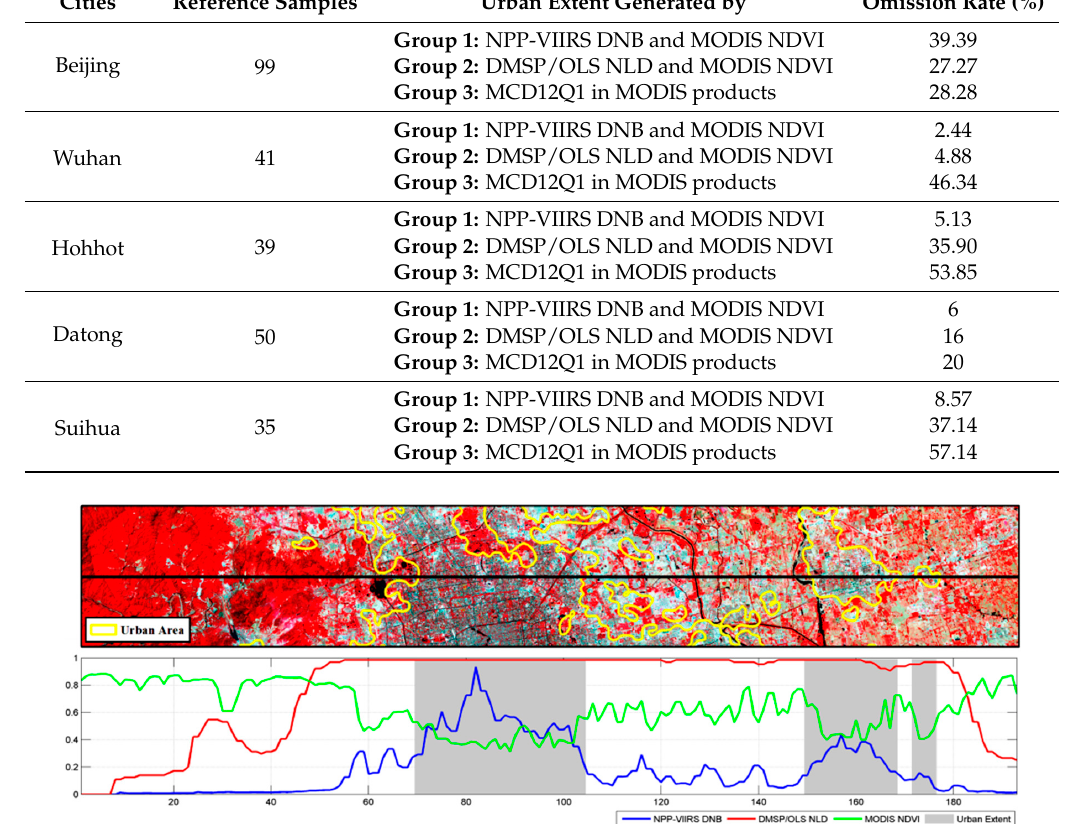
Figure 9. Latitudinal transects of the normalized NPP-VIIRS DNB, the normalized DMSP/OLS NLD and MODIS NDVI along one transect (the black guide line) in Beijing.